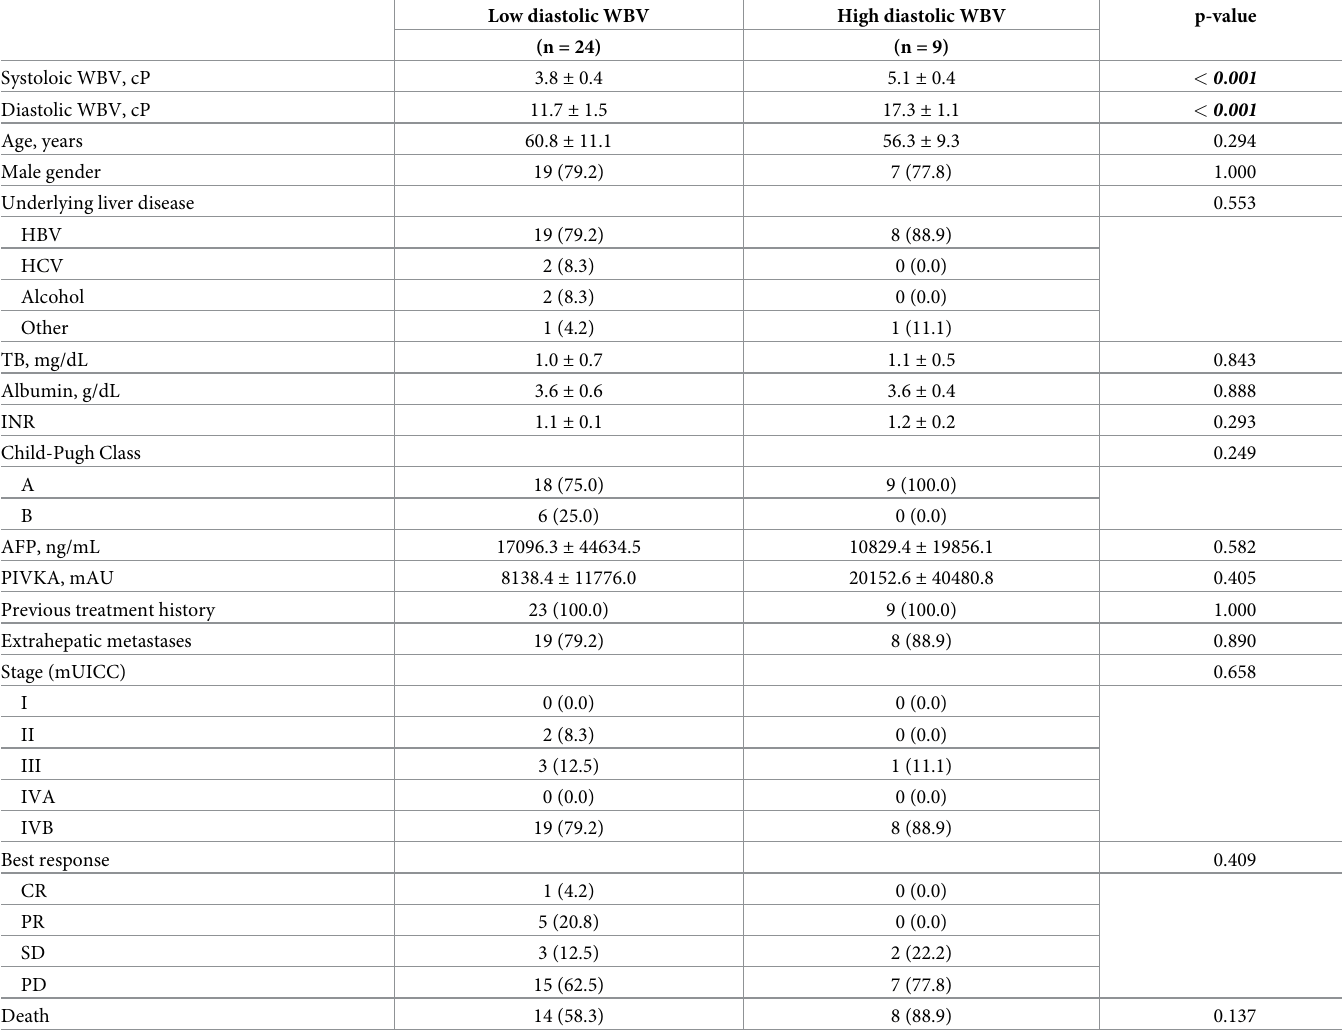
Table 5. Comparison between the patients with high ( > 16.0 cP) diastolic WBV and low diastolic WBV ( ≦ 16.0 cP) patients with nivolumab